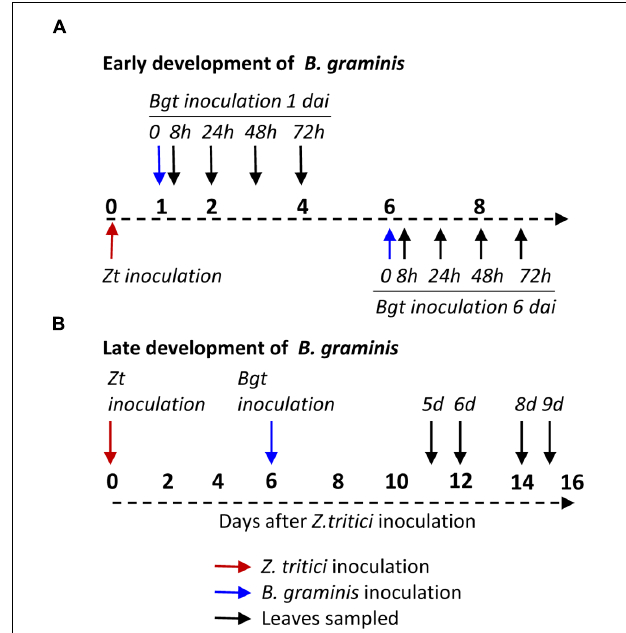
FIGURE 1 | Experimental design to investigate early and late development of Blumeria graminis f.sp. tritici on wheat leaves after inoculation with Zymoseptoria tritici . (A) Inoculation and data collection points to study the early development of Bgt on wheat leaves after inoculation with Z. tritici at day 0. (B) Inoculation and data collection points to study the late development of Bgt on wheat leaves after inoculation with a Z. tritici at day 0. In this figure, dai refers to days after inoculation with Z. tritici . h and d refer to hours or days at which leaves were sampled following inoculation with Bgt